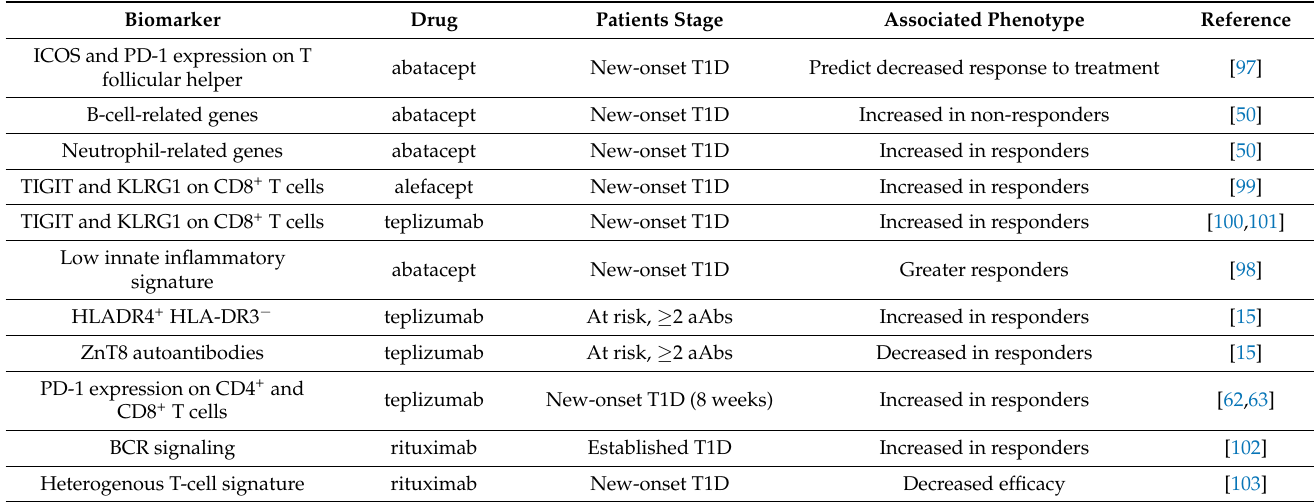
Table 1. Biomarkers identifying responders and non-responders to immunotherapies in T1D patients.